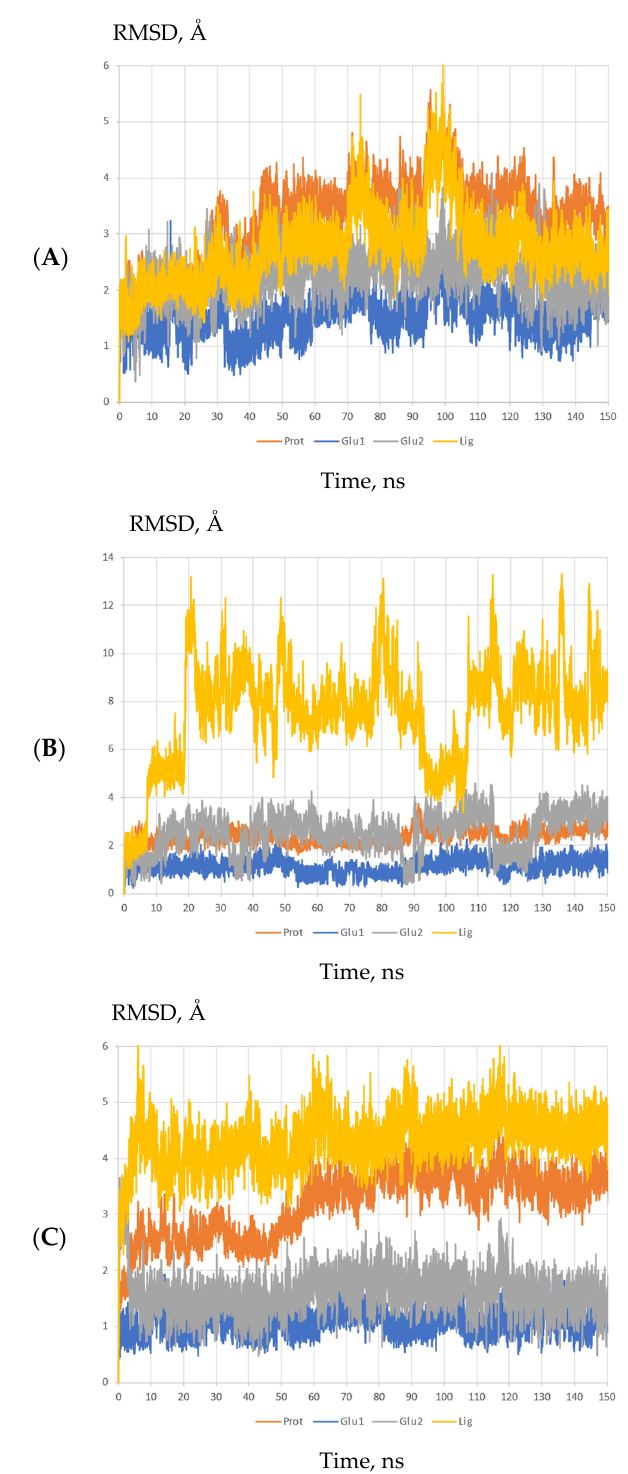
Figure 6. RMSD of the protein, glutamate, and ligand (( A )— 1f , ( B )— 1i , ( C )— 1j ) heavy atoms during molecular dynamics simulation of the modulator complex with the dimeric ligand binding domain of the GluA2 AMPA receptor.